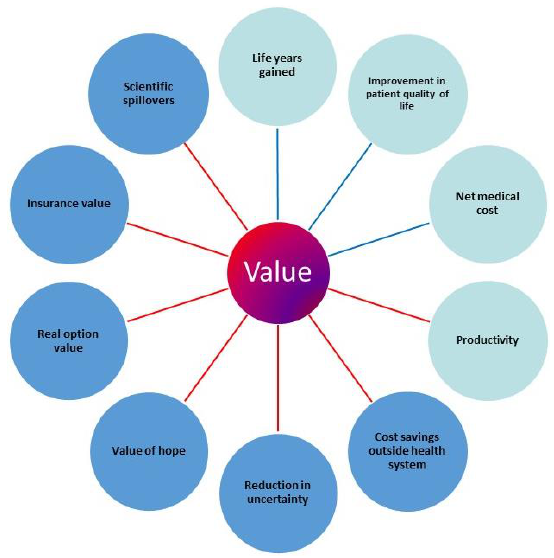
Figure 1. Dark blue circles: proposed information-related elements of value; Light blue circles: traditional Health Technology Assessment (HTA) and other societal elements of value; Blue line: value element in traditional HTA/health system perspective; Red line: additional value element also included in societal perspective. Source: Adapted from Figure 1 in Garrison et al. [6]